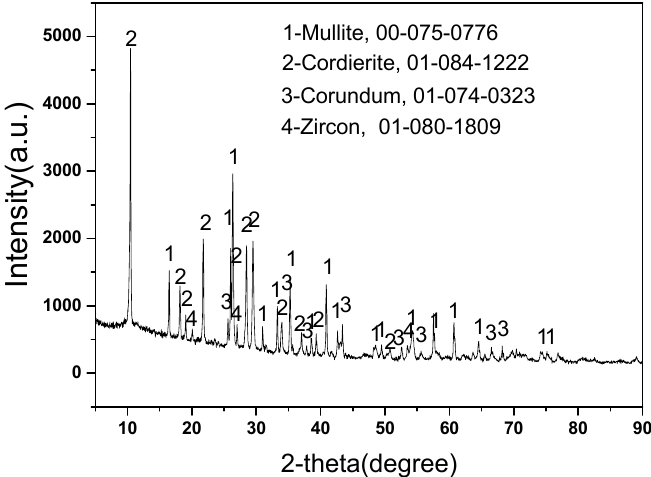
Figure 1. XRD pattern of new mullite–cordierite ceramic saggar (with relative ICDD PDF-4 card numbers).